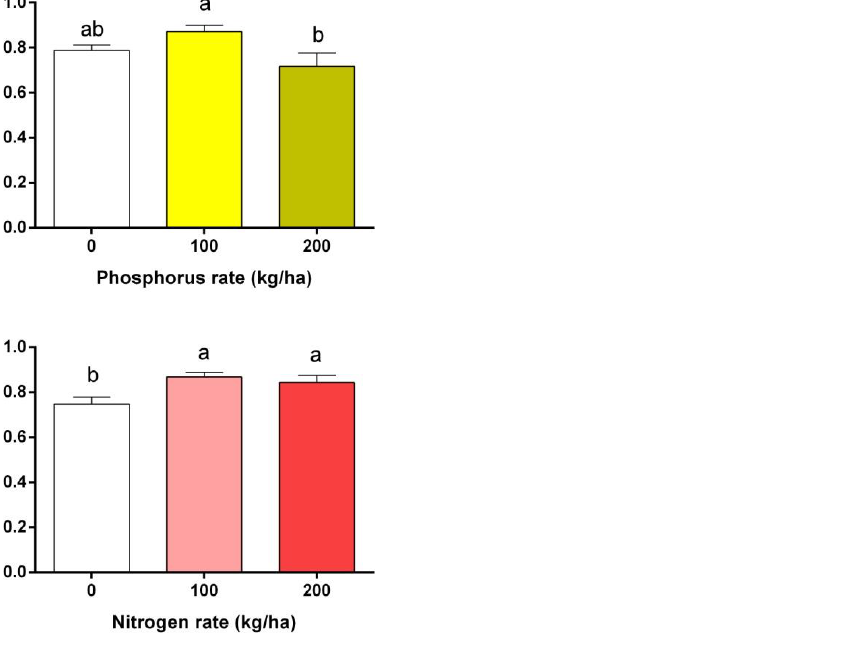
Figure 3. Effect of P application in early flowering ( A ) and effect of N application in late flowering ( B ) on quantum yield PSII. Different letters on the top of the bars indicate significant difference at p < 0.05 by Duncan.